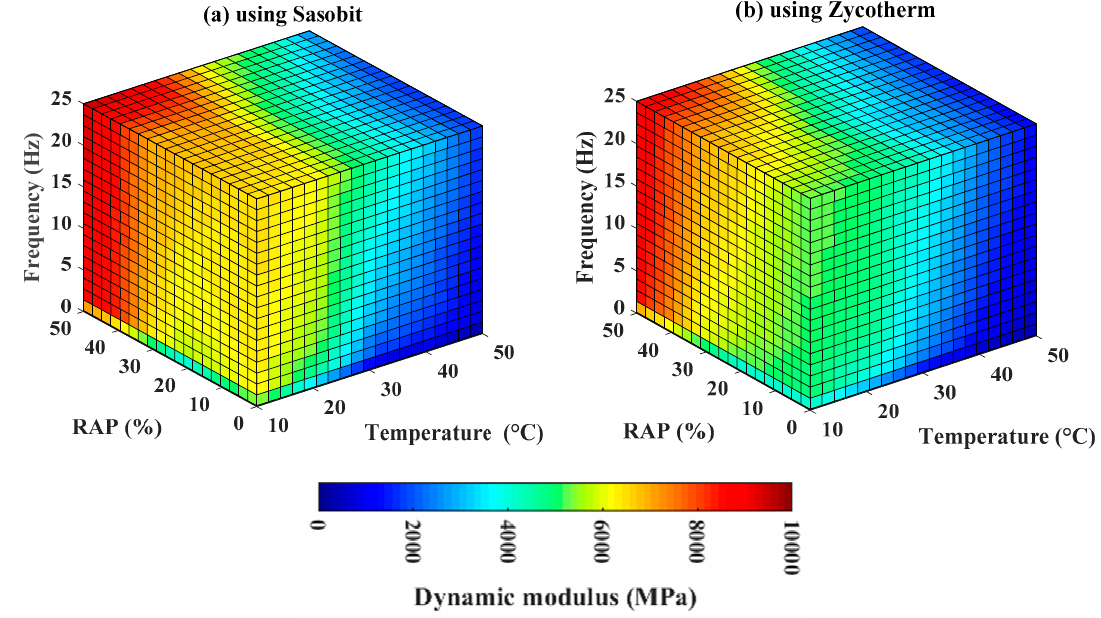
Figure 7. Box map sensitivity analysis at different %RAP contents, frequencies, and temperatures using ( a ) Sasobit; and ( b ) Zycotherm.